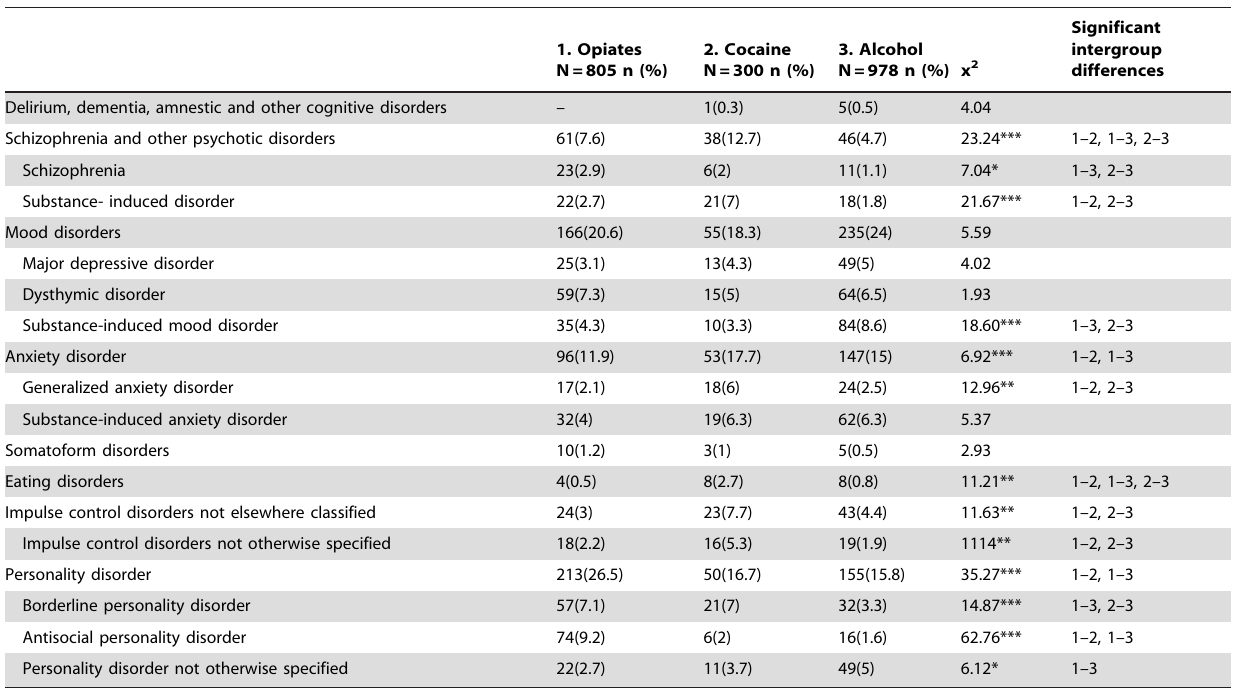
Table 5. Diagnostic categories and most frequent diagnoses per